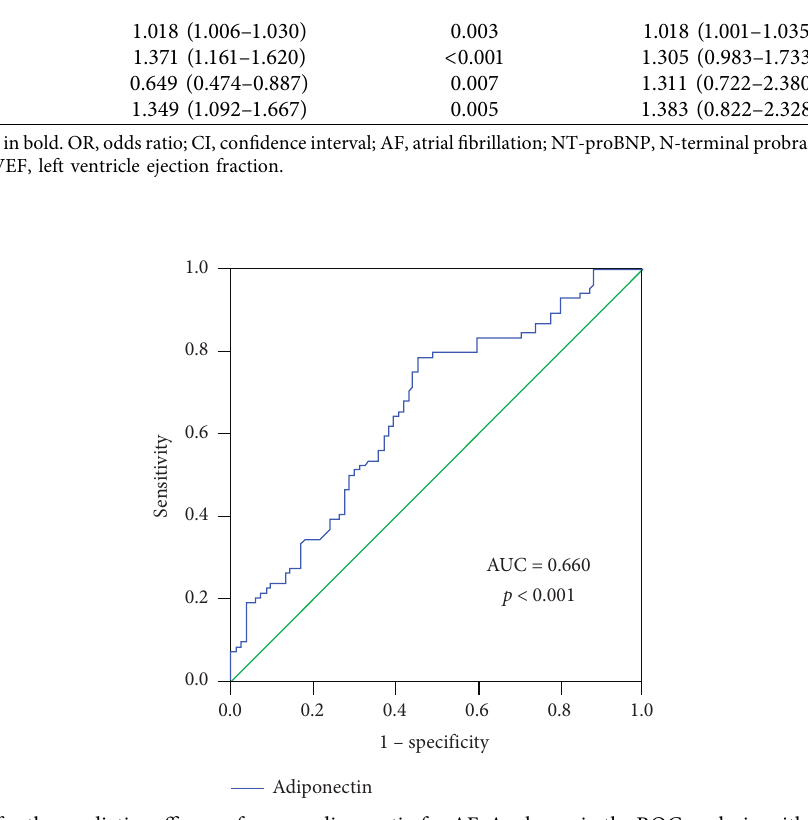
Figure 3: ROC analysis for the predictive efficacy of serum adiponectin for AF. As shown in the ROC analysis, with an optimal cut-off value of 6.098 μ g/mL, the sensitivity and specificity of serum adiponectin for predicting AF were 78.6% and 54.8%, with an AUC of 0.660 (95% CI: